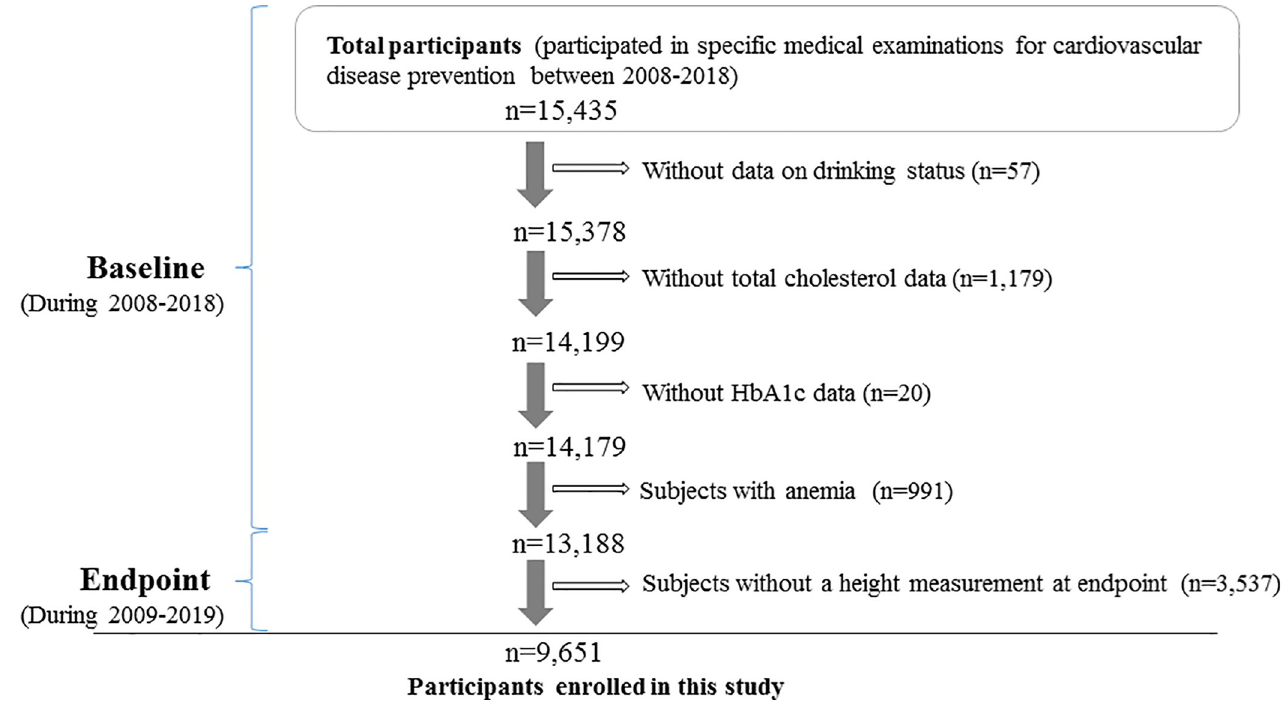
Fig 1. Demographics of study